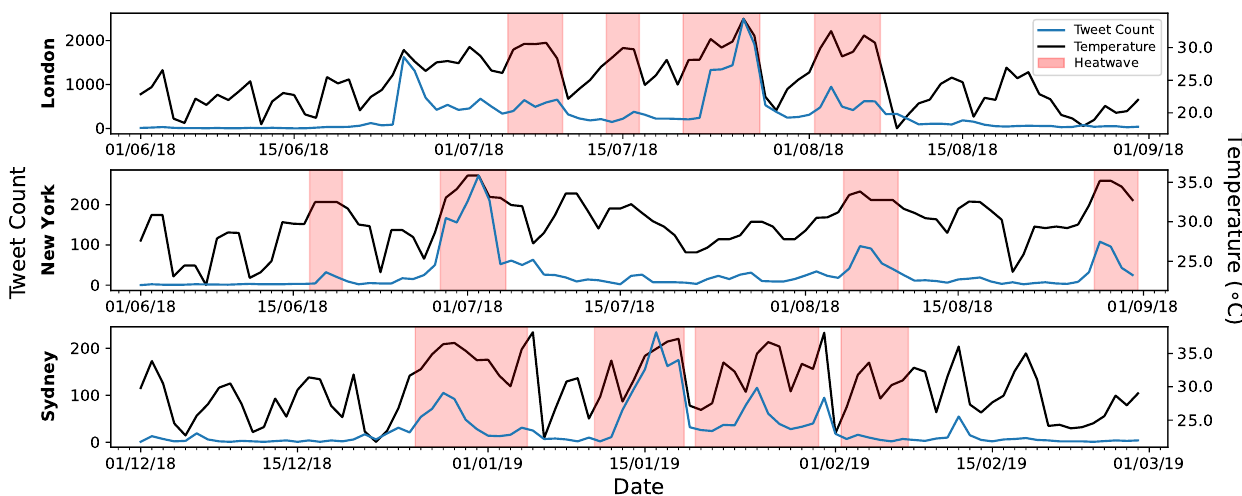
Figure 5. Daily tweet count in the investigated cities, overlaid with the government defined heatwave days and the average daily maximum temperature (ADMT).